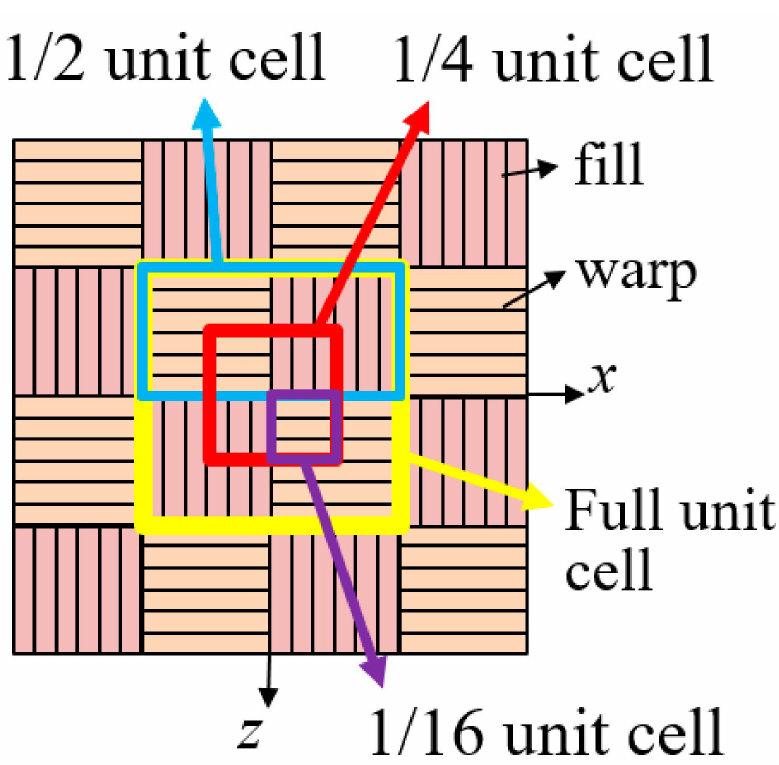
Figure 2. Full and partial unit cells of plain weave textile